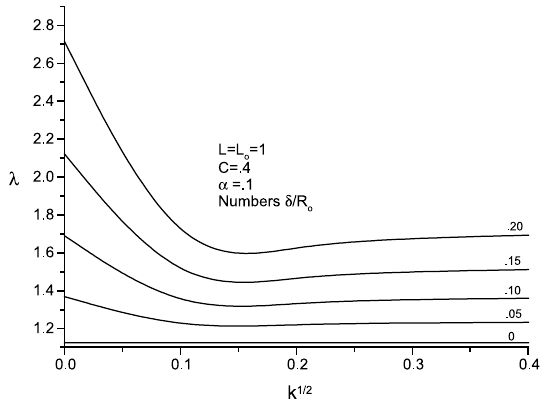
Fig.7. Impedance, λ versusDarcynumber,k 1 / 2 fordifferentstenosis height, δ/ R o .